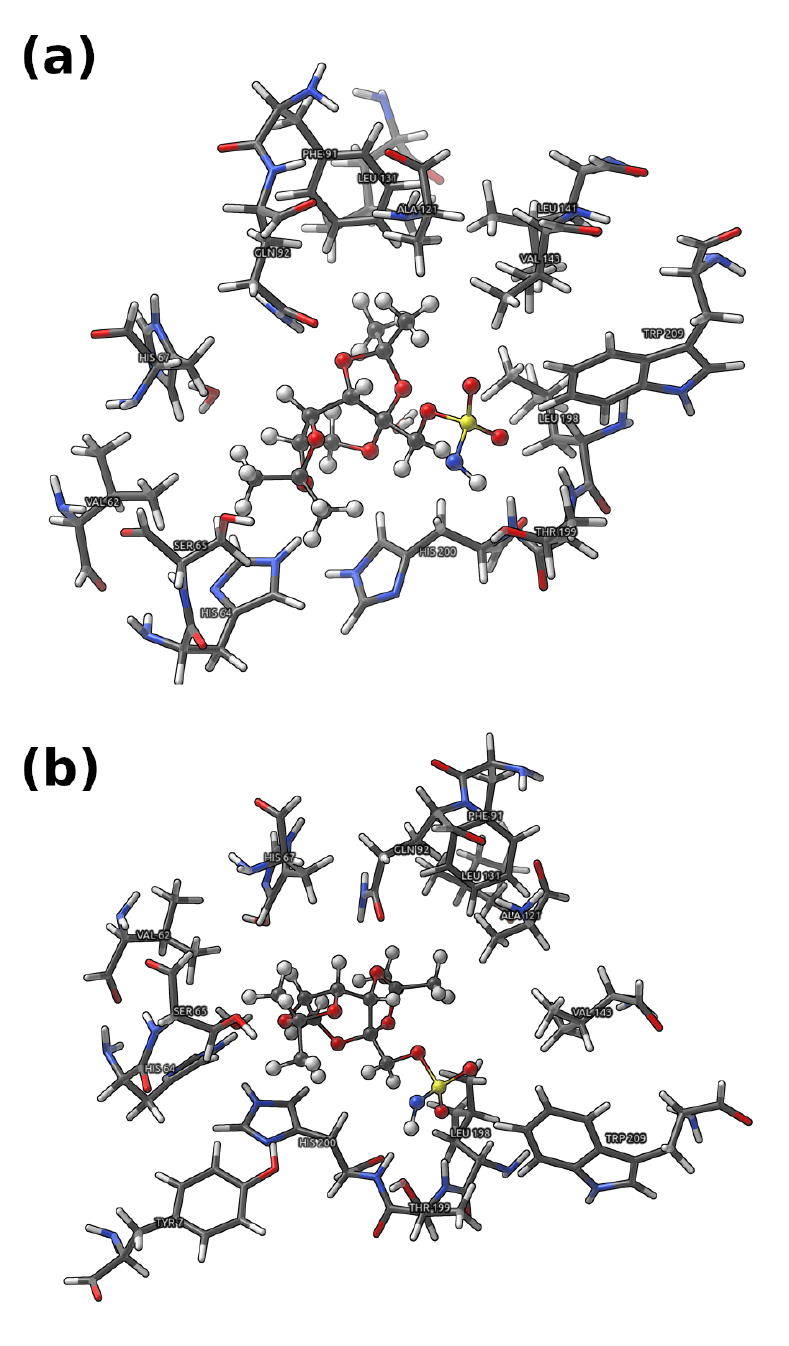
Figure 2. Graphical representation of the large model used in the present study. ( a ) denotes model analyzed at 5 and 10 ps (only atoms positions with respect to the ligand changed—all taken amino acids were the same for 5 and 10 ps; visualization is based on the atoms configuration taken at 5 ps of the simulation time), whereas ( b ) denotes model obtained as a third snapshot (15 ps) of the QM/MM run. The amino acids in the binding site are presented using licorice while the ligand—Topiramate using CPK. Color coding: white—hydrogen, grey—carbon, red—oxygen, blue—nitrogen, and